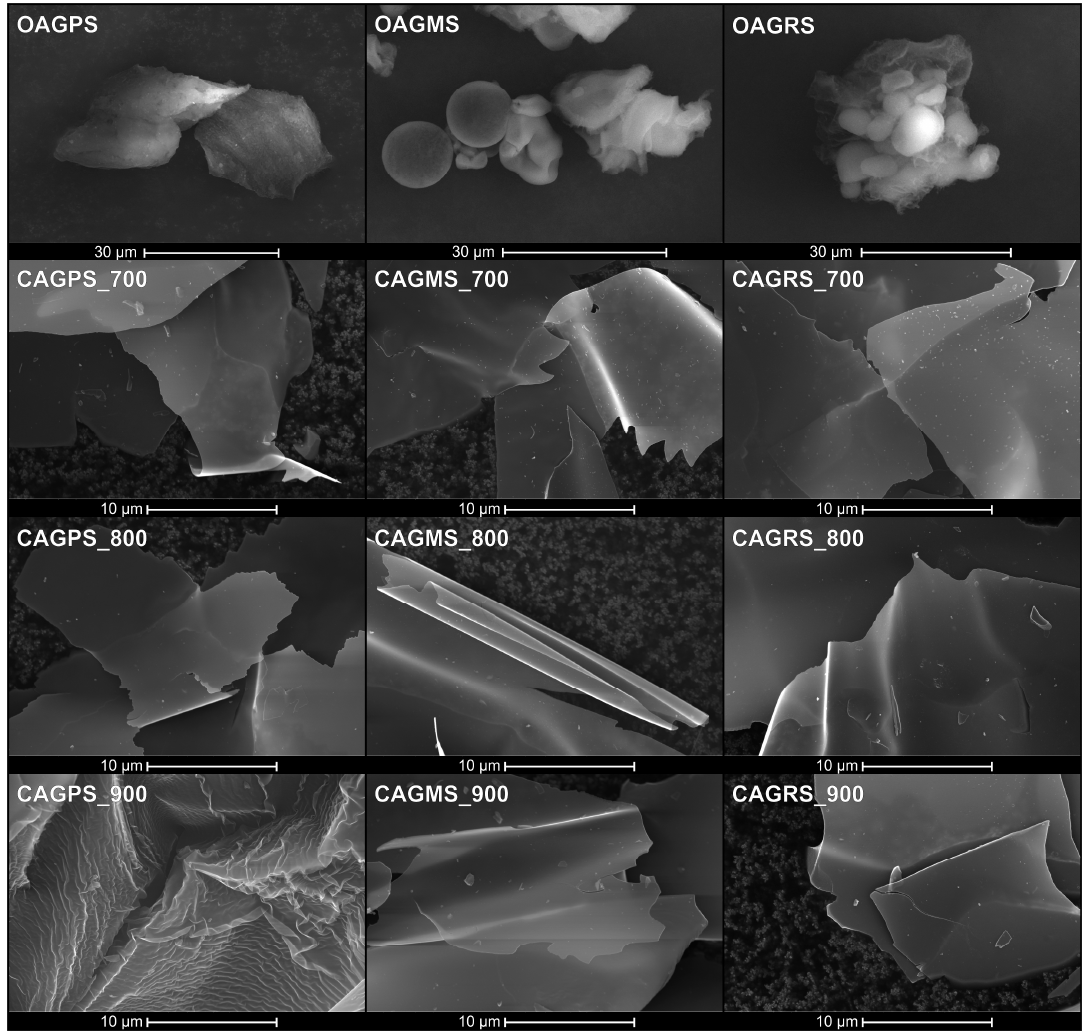
Figure 3. SEM micrographs of organic and carbon aerogels (CAGs) pyrolysed at 700 °C, 800 °C, and 900 °C obtained from different starches (PS: potato starch, MS: maize starch, RS: rice starch).